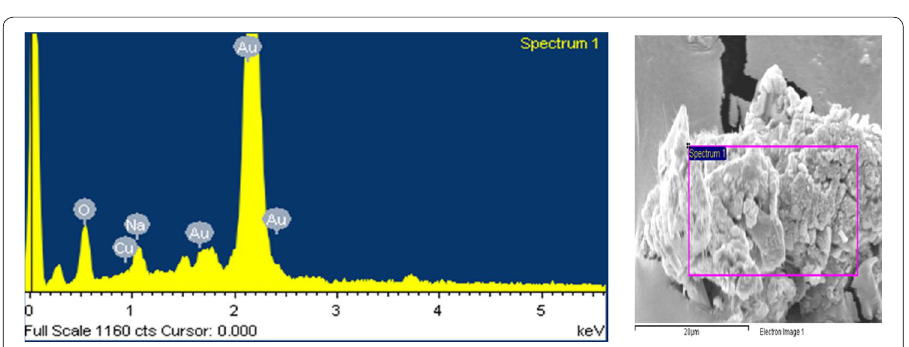
Fig. 3 EDS spectra of copper nano particles